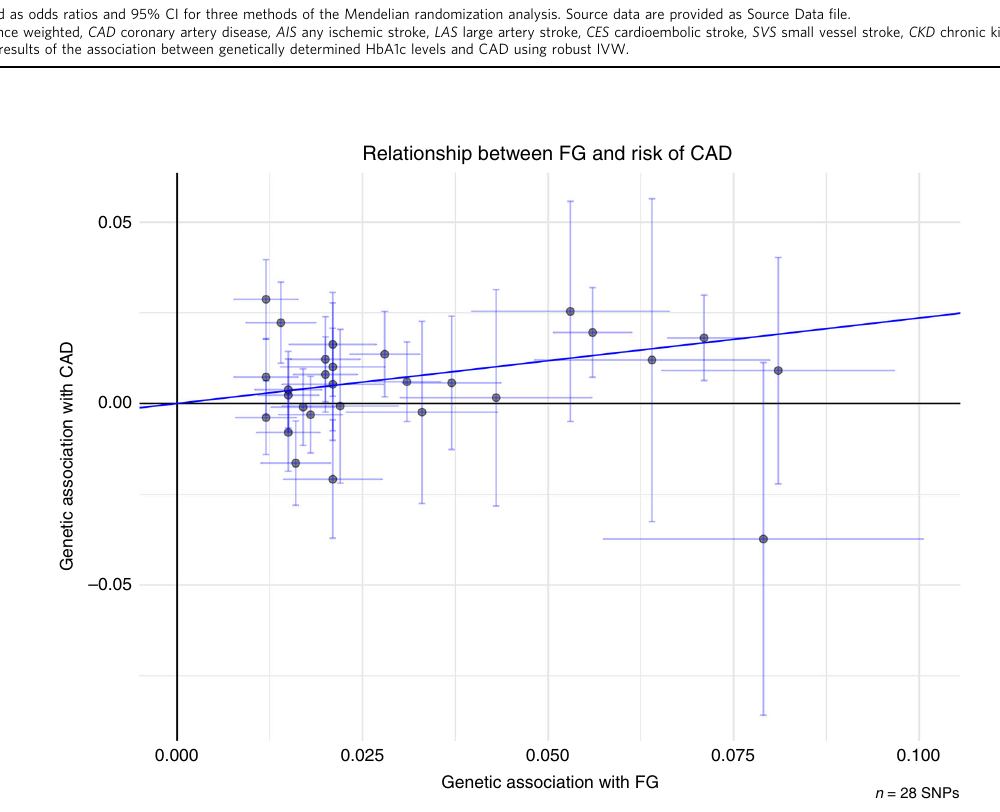
Fig. 2 Relationship between genetic effects of prediabetes only and CAD. Data are represented as log-odds and 95% con fi dence intervals for each trait. Slope of the line represents an estimate of the causal effect of fasting glucose on risk of CAD. The points represent effect sizes for each individual genetic variant (SNPs) for each of the traits on both axes. The horizontal and vertical bars at each point represent the 95% con fi dence intervals for genetic associations with FG and CAD, respectively. FG fasting glucose, CAD coronary artery disease. Source data are provided as Source Data fi